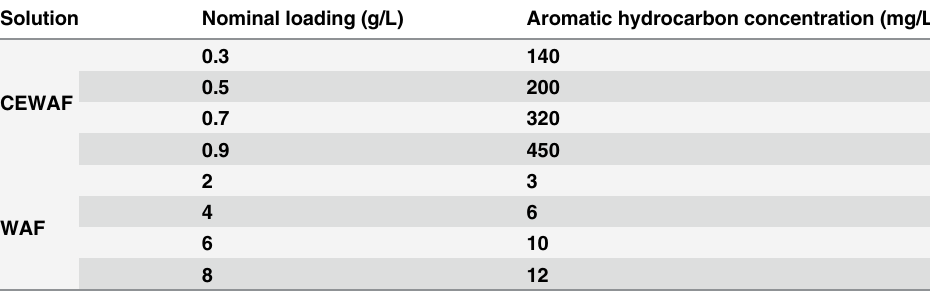
Table 1. Nominal oil loadings and aromatic hydrocarbon concentrations of WAF and CEWAF samples.